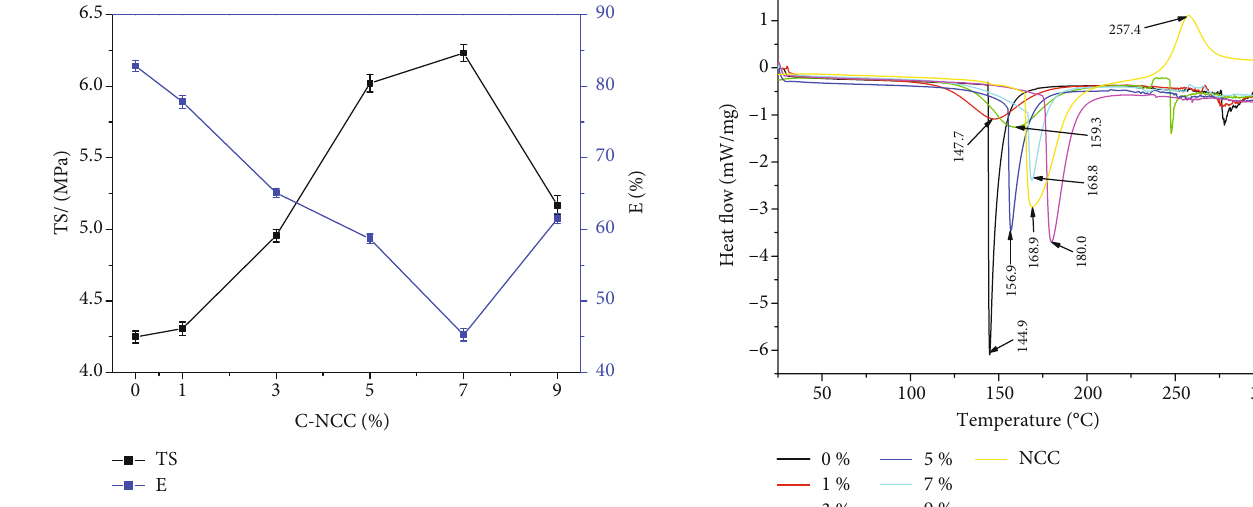
Figure 5: E ff ect of the C-NCC content on mechanical properties of the composite fi lms.